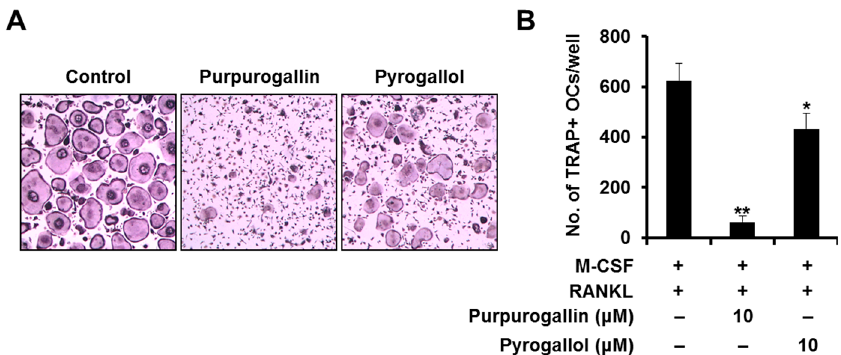
Figure 5. Purpurogallin inhibits osteoclast differentiation more effectively than pyrogallol. ( A ) BMMs were cultured with M-CSF (10 ng/mL) and RANKL (20 ng/mL) in the presence of purpurogallin or pyrogallol (10 μ M). The cells were stained for TRAP; ( B ) TRAP-positive cells with more than three nuclei were scored. * p < 0.05, ** p < 0.01 versus vehicle-treated control.